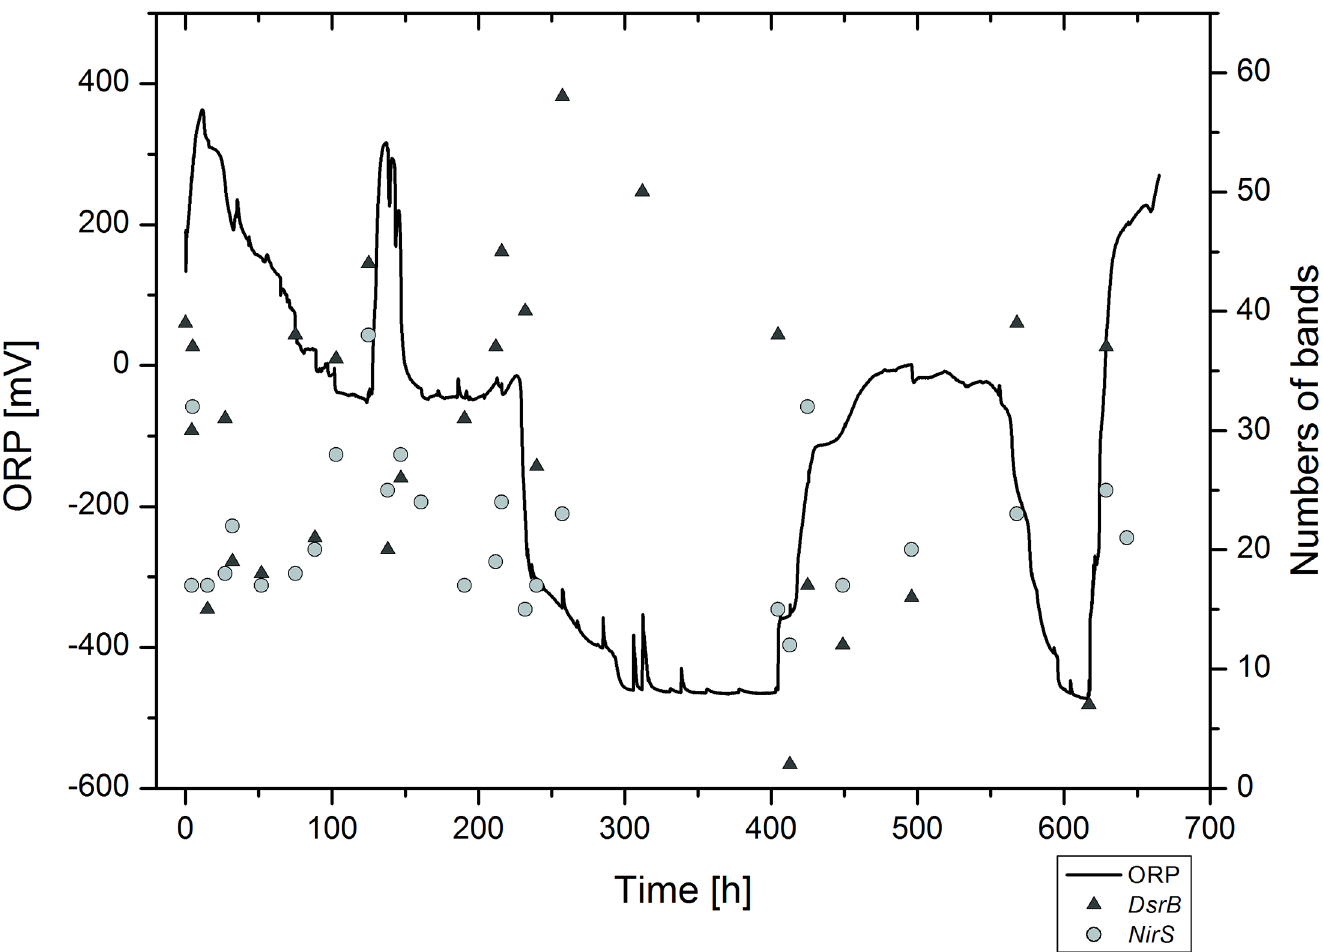
Fig 4. Development of dsrB and nirS DGGE band diversity in relation to